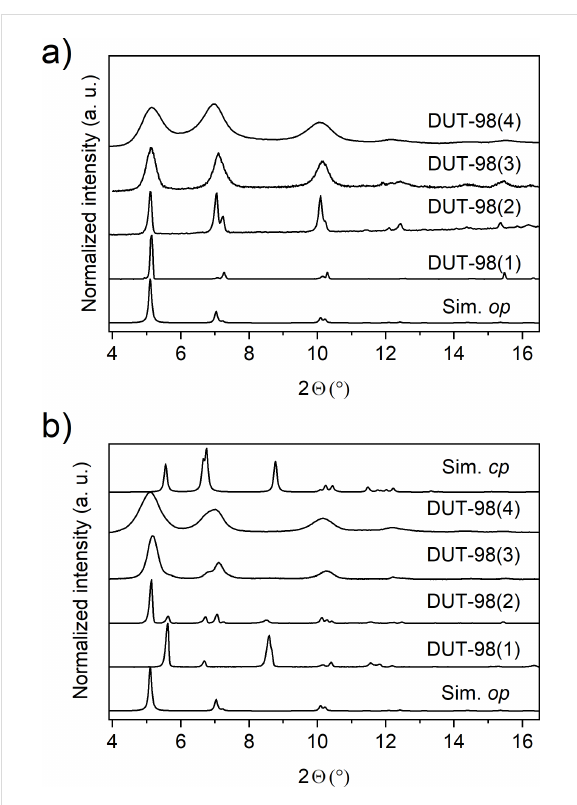
Figure 4: Powder XRD patterns of DUT-98 with varying crystal size a) as-synthesized and b) activated by supercritical solvent removal.